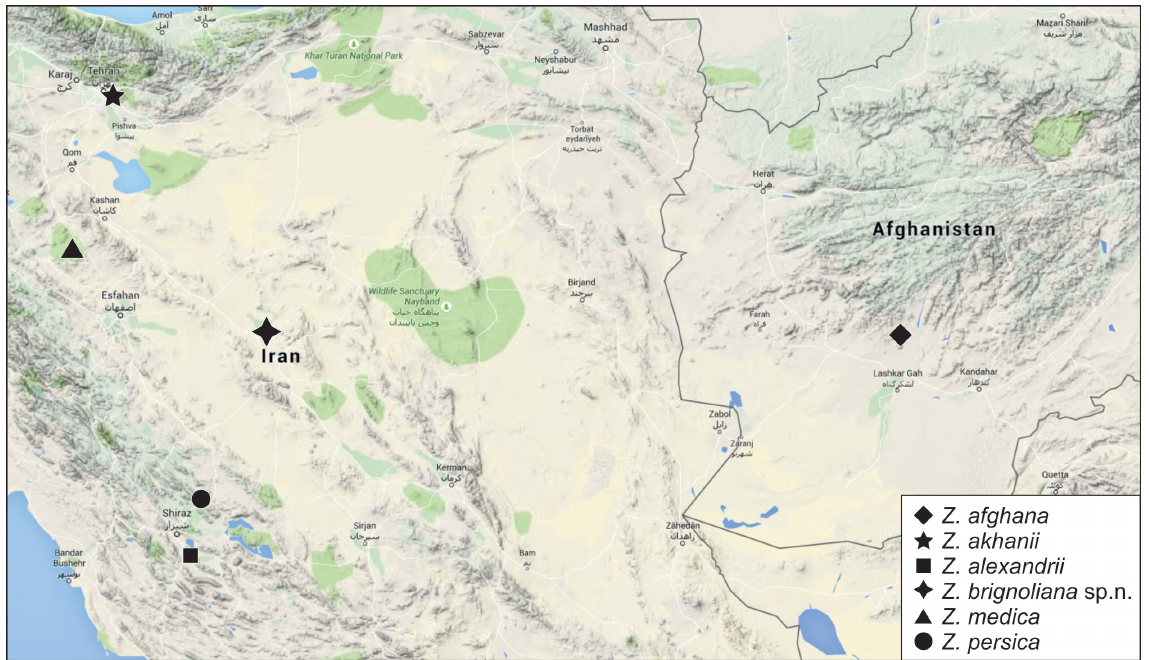
Fig. 47. Distribution of Zaitunia persica species